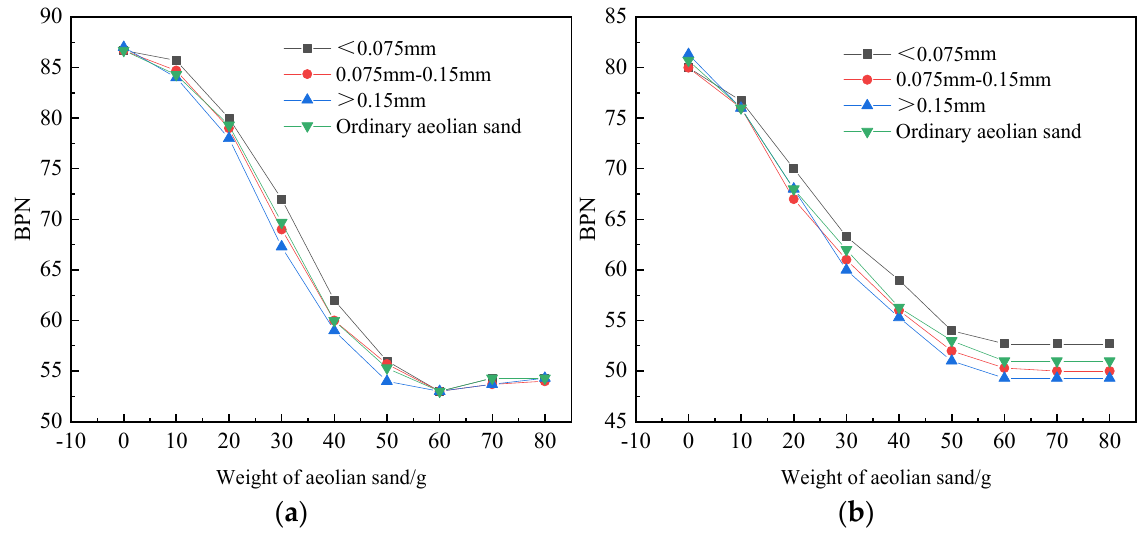
Figure 11. BPN value of aeolian sand with three particle sizes existing alone on the road surface. ( a ) BPN value of aeolian sand with three particle sizes existing alone on the AC-16 pavement surface; ( b ) BPN value of aeolian sand with three particle sizes existing alone on the AC-13 pavement surface.